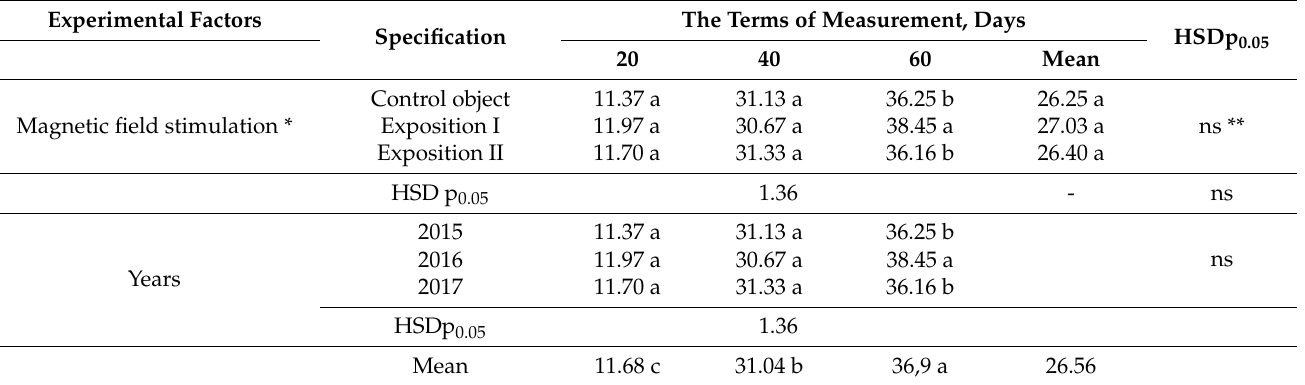
Table 3. Effect of stimulation of seeds and dates of measurement on the amount of common bean plants (cm).